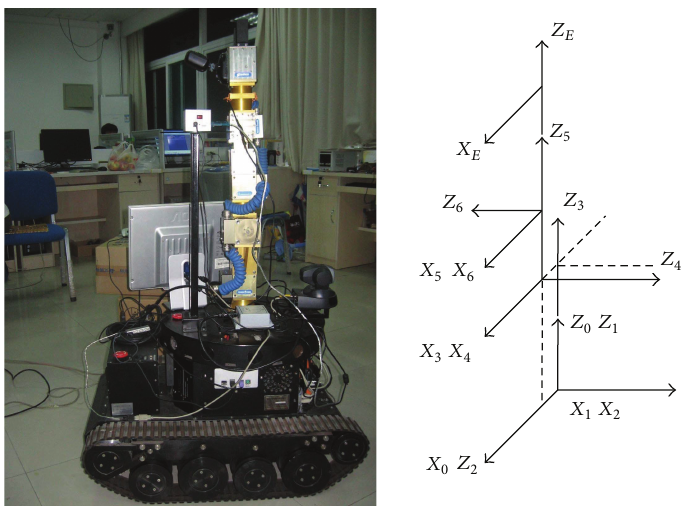
Figure 2: Vision-based mobile manipulation system and its link coordinate